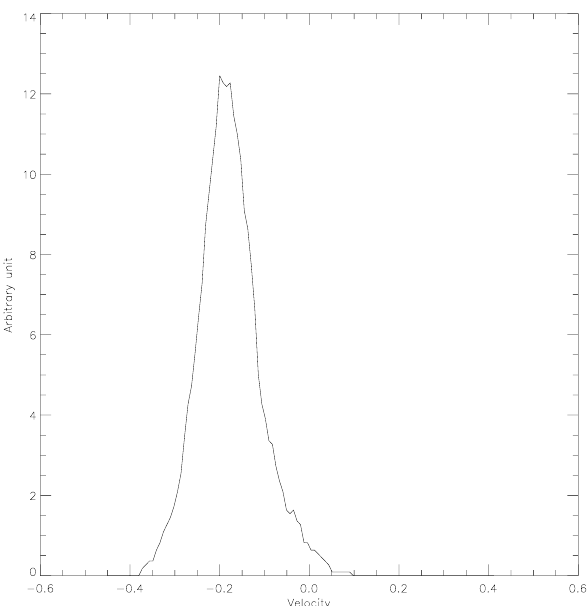
Fig. 4. Electron velocity distribution function leading to the Bune- man instability at ω pe t = 320 and Z = 162 c/ω pe (below label 2 in Fig. 2) in the density gradient